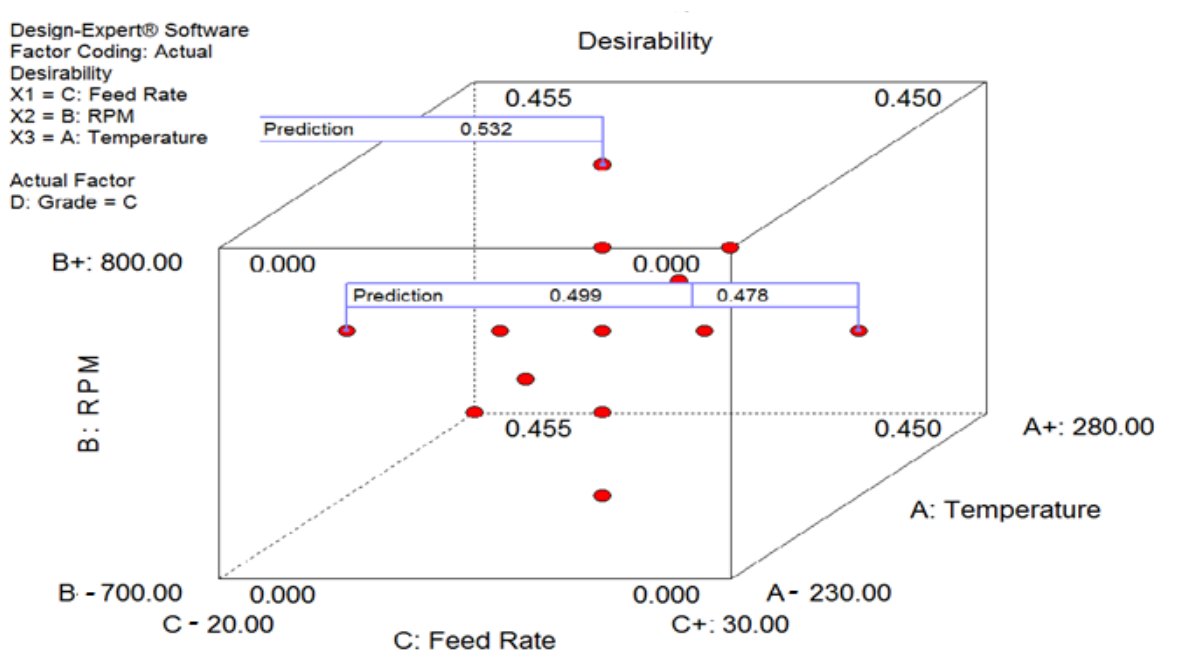
Figure 10. Cube desirability between grade 3 and dE*.